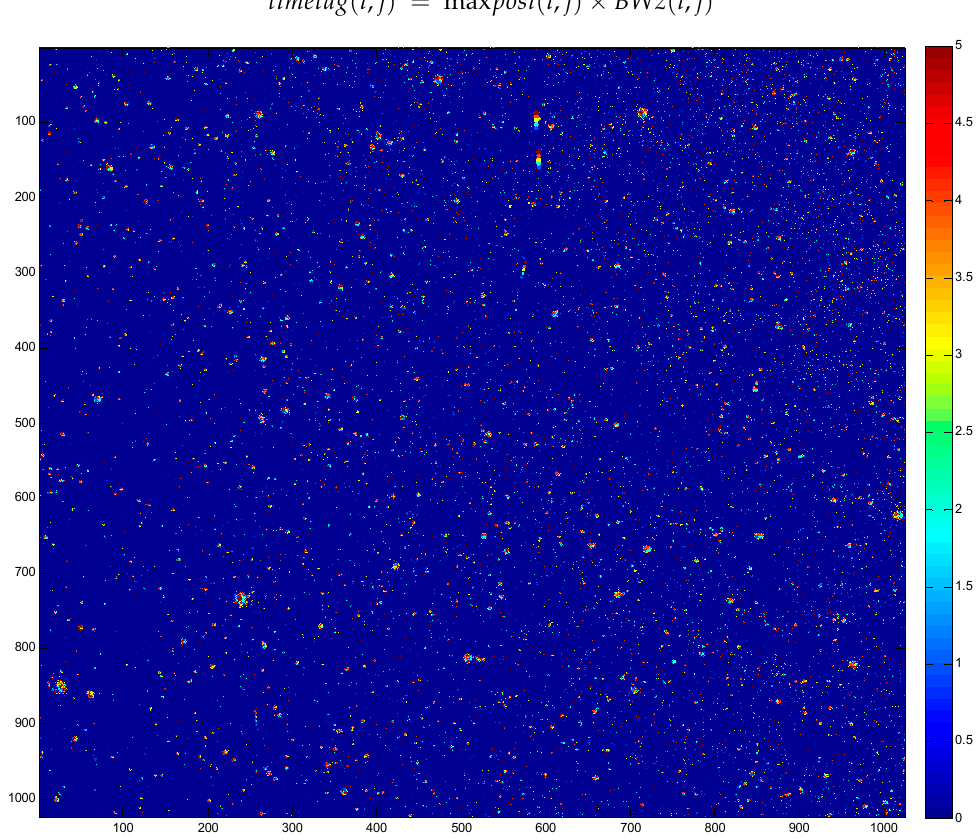
Figure 6. Maximum projection image time information frame.